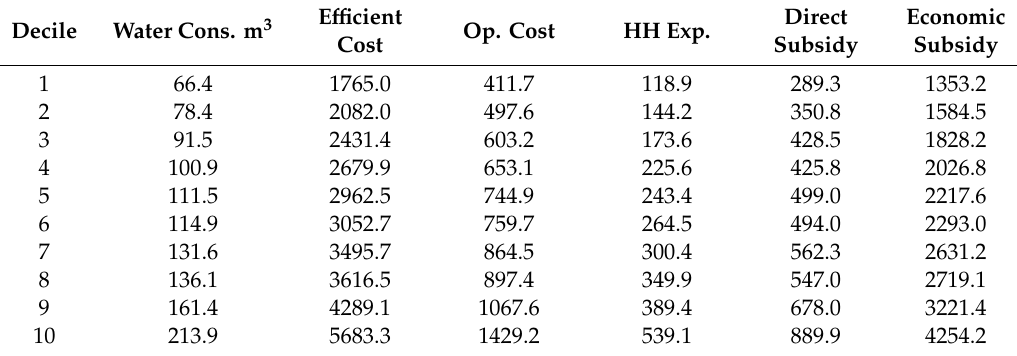
Table 6. Estimated average residential subsidies